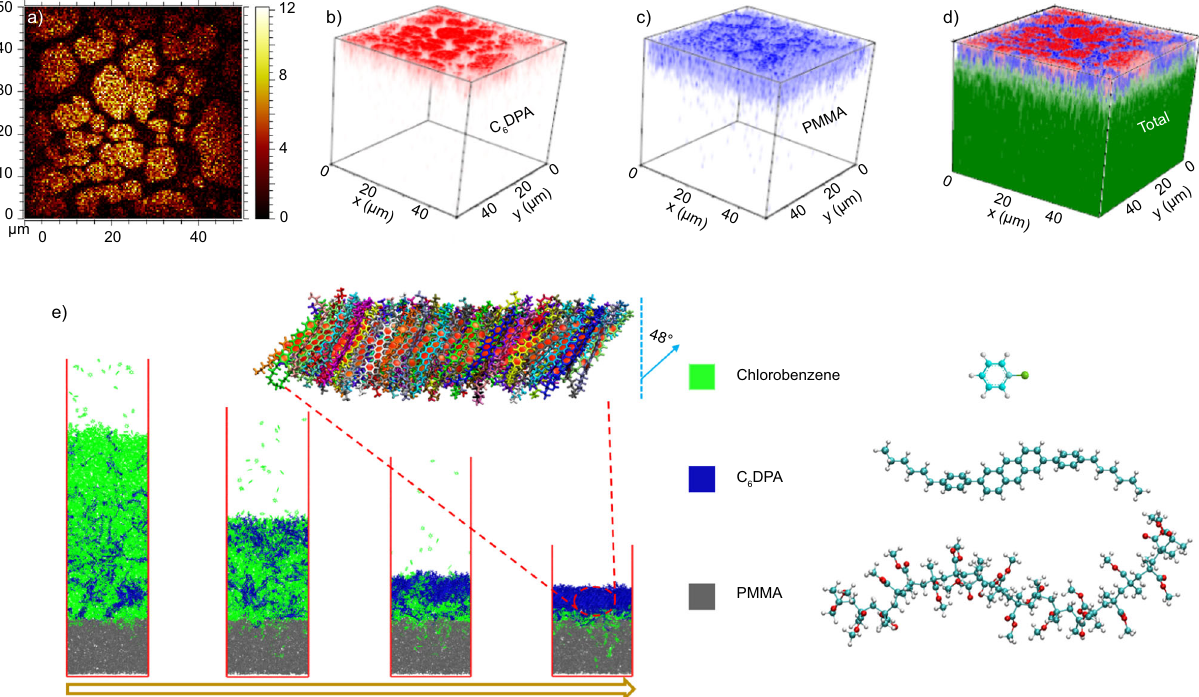
Fig. 2 Distribution and self-assembly process of C 6 DPA MMCs. a – d Time of fl ight secondary ion mass spectrometry (TOF-SIMS) images of C 6 DPA MMCs: a two-dimensional TOF-SIMS images of C 38 H 41 + corresponding to C 6 DPA (the bright colors represent C 6 DPA). b – d 3D analysis of C 38 H 41 + (C 6 DPA, red colors), C 5 H 9 O 2 + (PMMA, blue colors), respectively and total ions (the green colors represent silicon), respectively, as a function of depth. e Molecular dynamics simulations of the formation of MMCs. The left scheme illustrates the formation process. The zoomed-in image on the top is the C 6 DPA molecular stacking